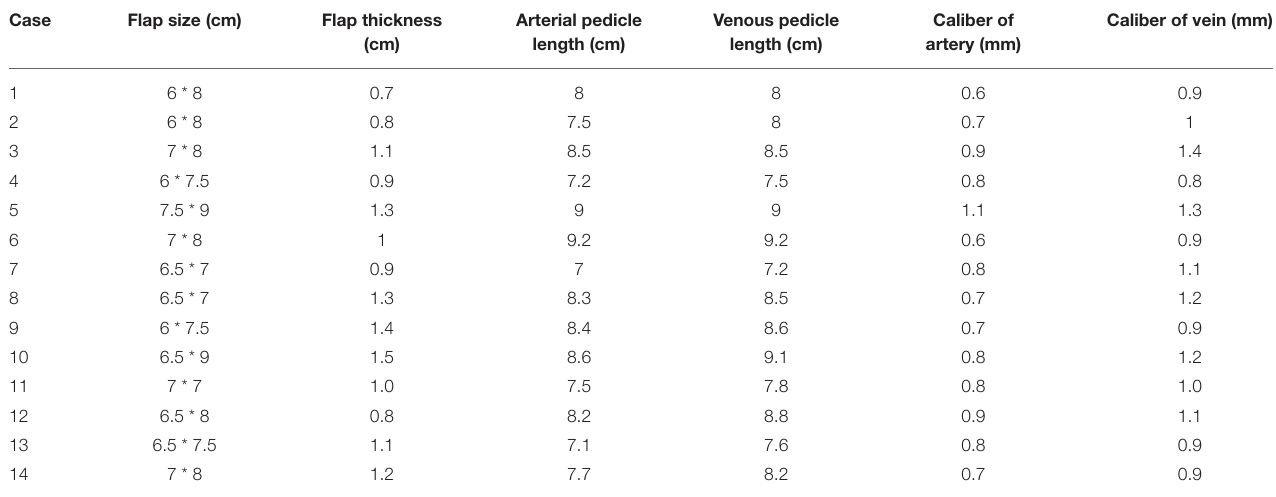
TABLE 2 | Detailed information of characteristics of SCIP flaps.